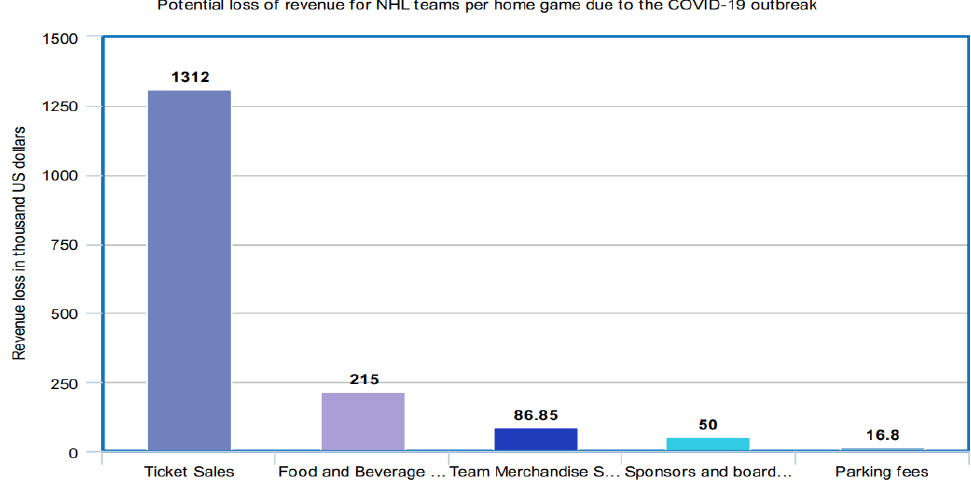
Figure 16. Potential loss of revenue for National Hockey League (NHL) teams per home game due to the COVID-19 outbreak